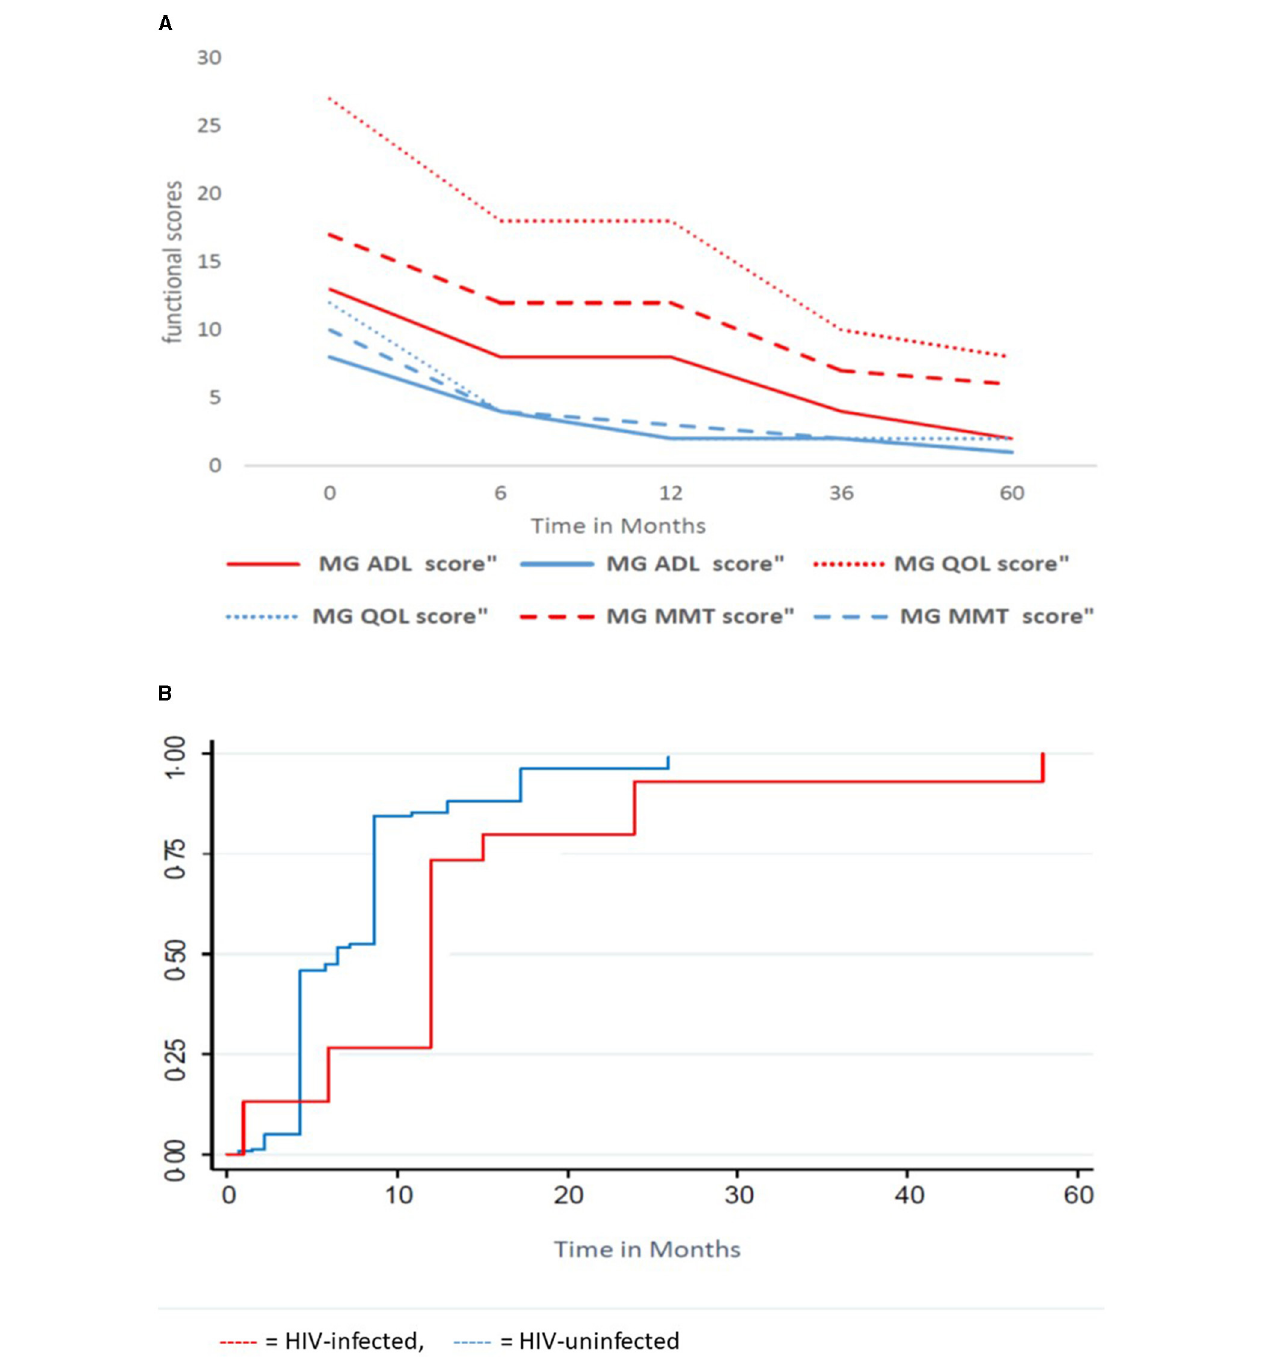
FIGURE 2 | Functional scores and time to remission for the HIV-infected and HIV-uninfected cohort. (A) Functional Scores over time, (B) Kaplan Meier Curve of survivor function. MMT, Manual Muscle Testing; ADL, Activity of daily living, QOL, Quality of life; , HIV-uninfected; ,